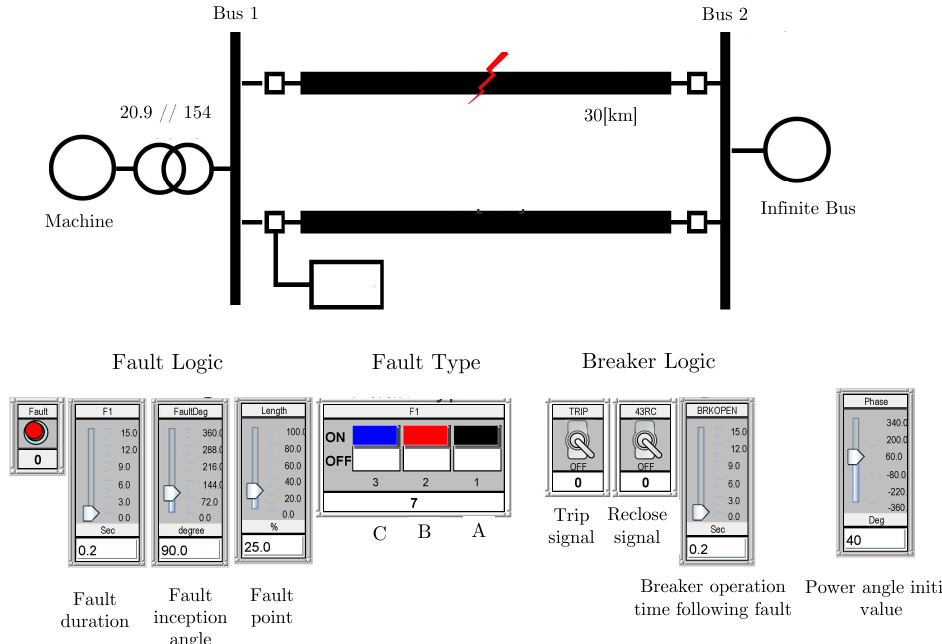
Figure 7. Single machine infinite bus system RSCAD runtime model.